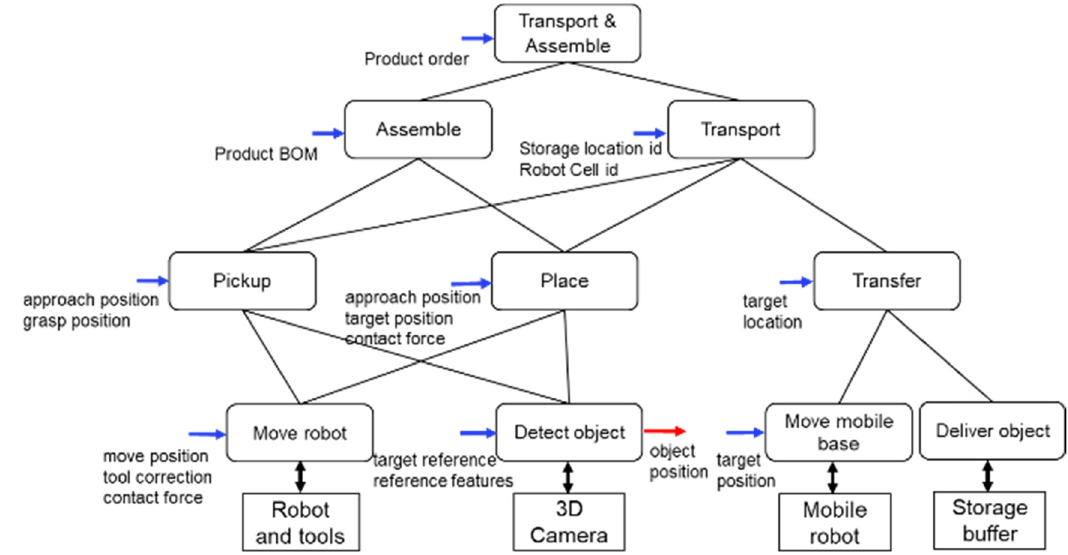
Figure 3: An example of a skill hierarchy for transport and assembly